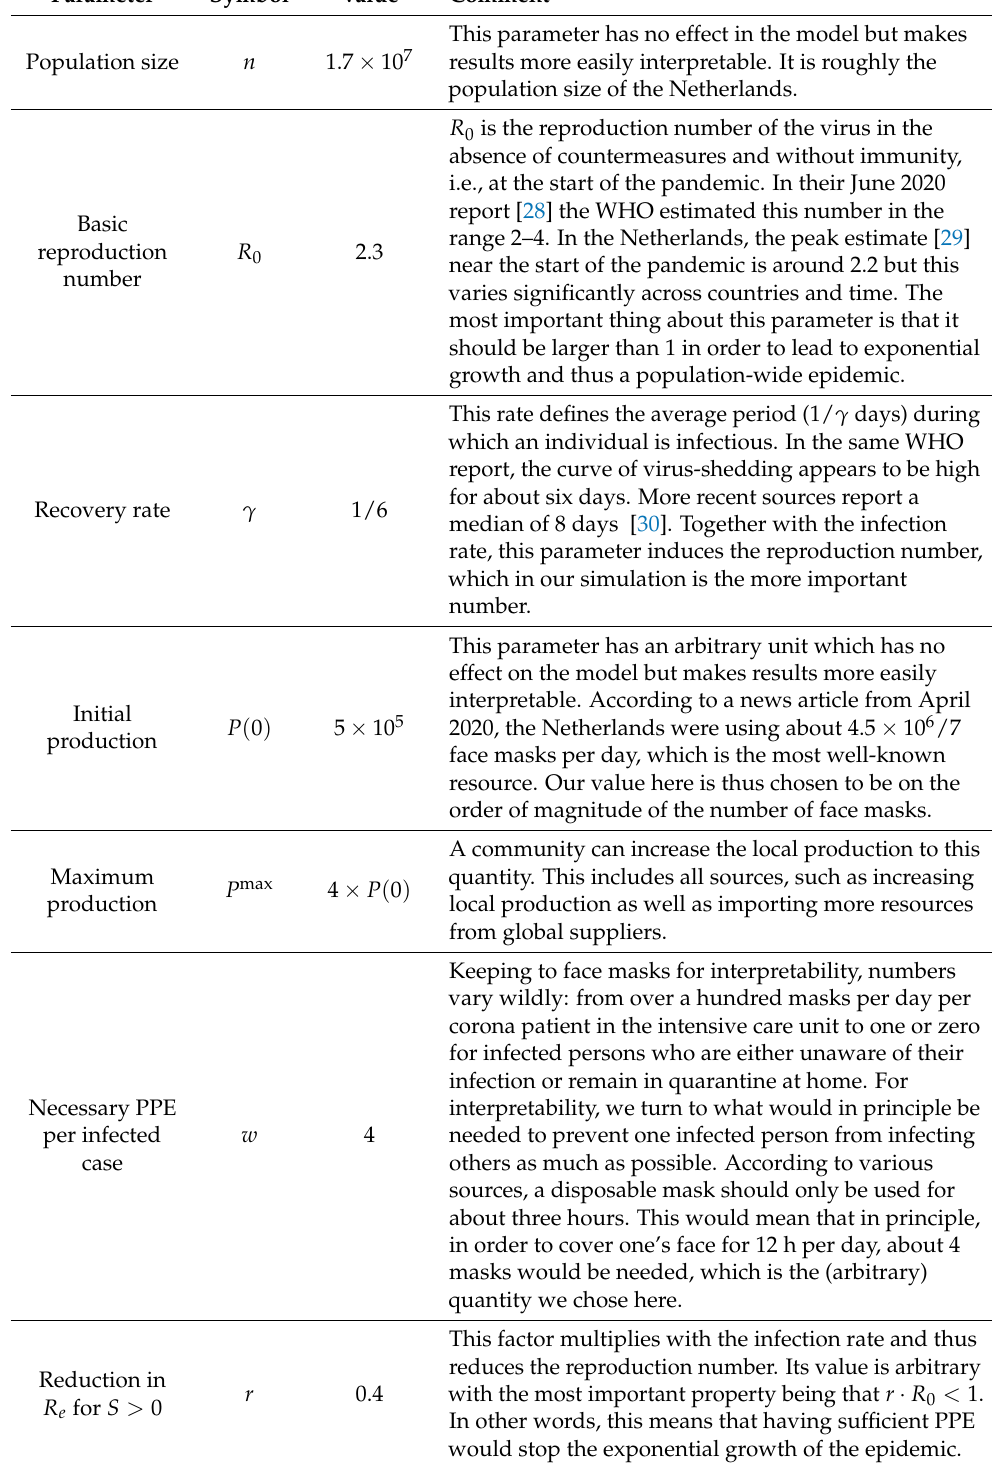
Table A1. Parameter settings used for the simulations in this